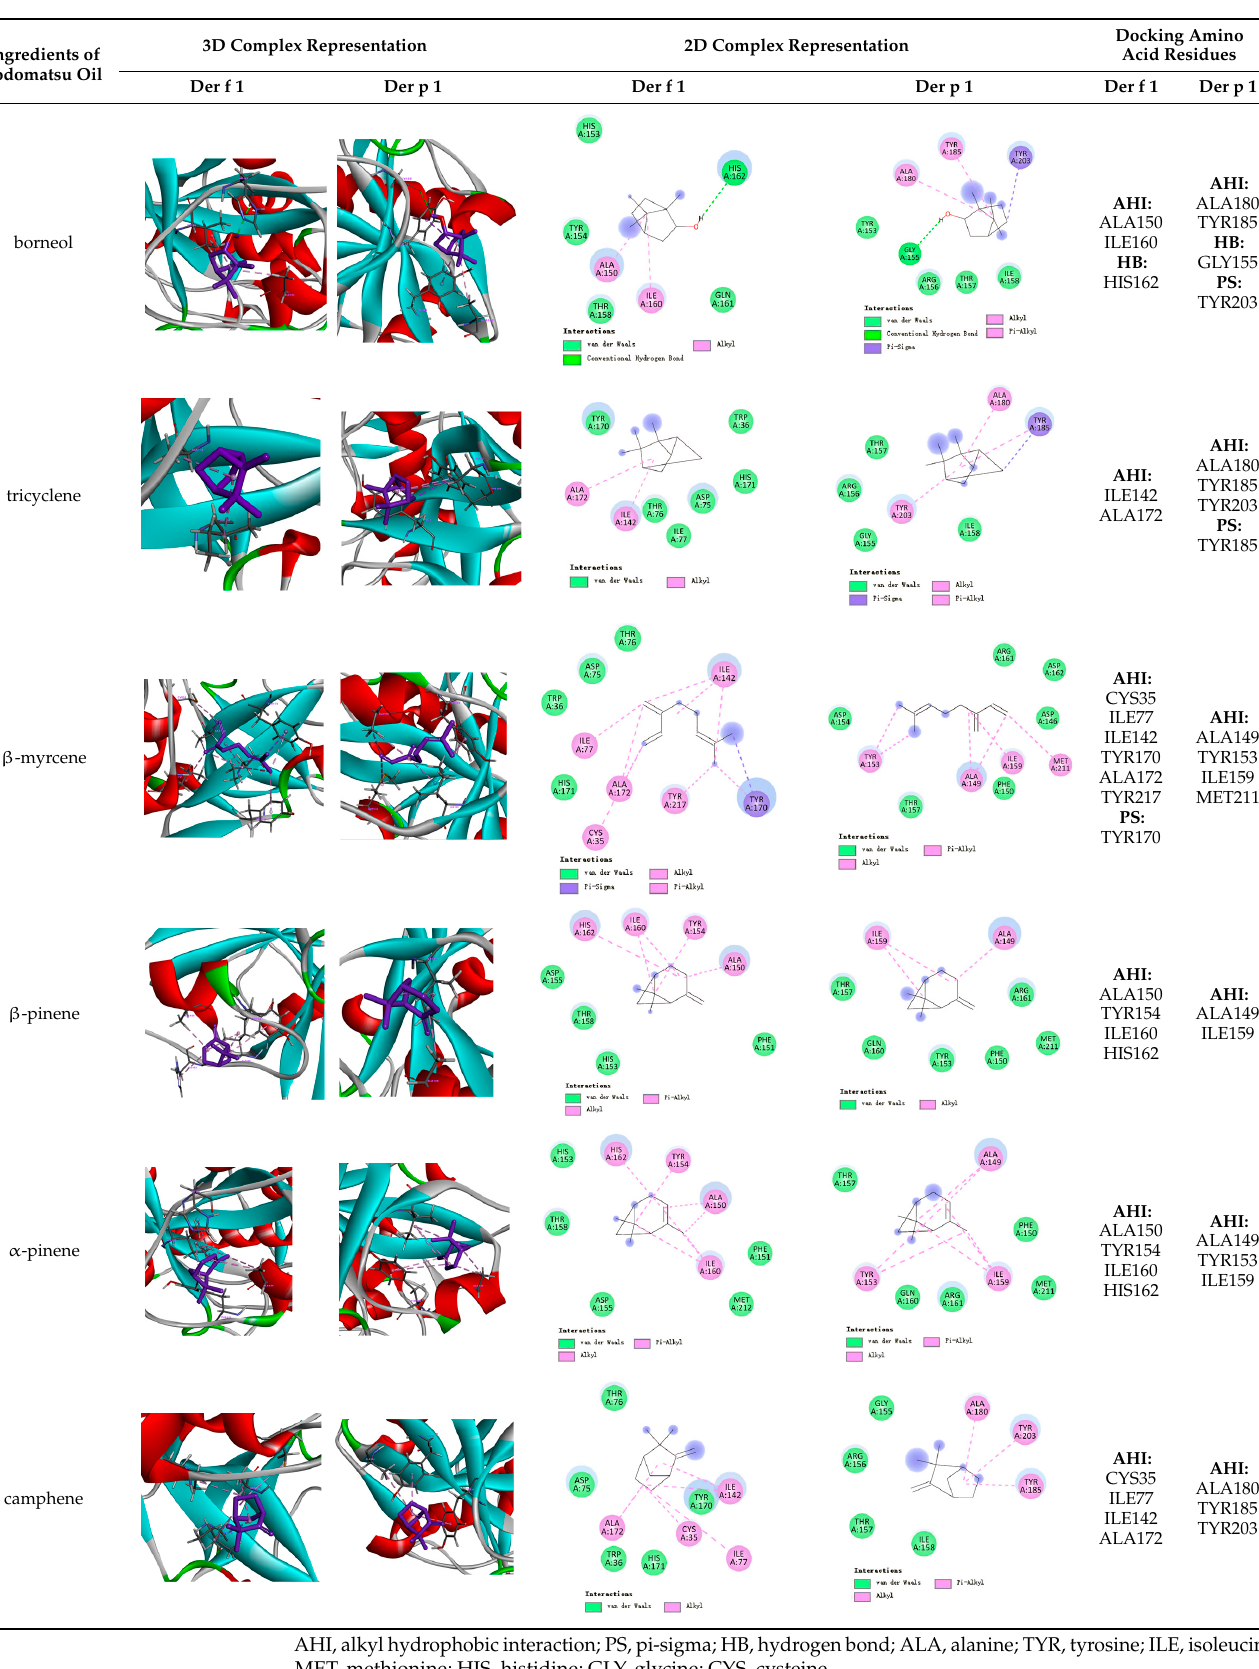
Table A2. Binding affinity (BA) score and inhibition constant ( Ki ) of ingredients-of-todomatsu oil on allergens Der f 1 and Der p 1. Ingredients of Todomatsu Oil